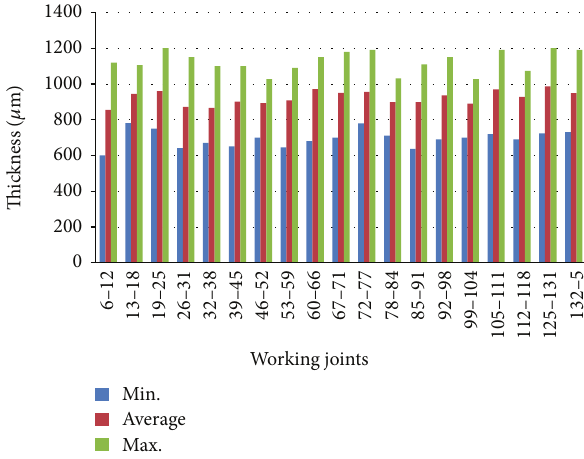
Figure6:Thicknesscorrosionprotectionofrebarwithcementitious coating for external shell.